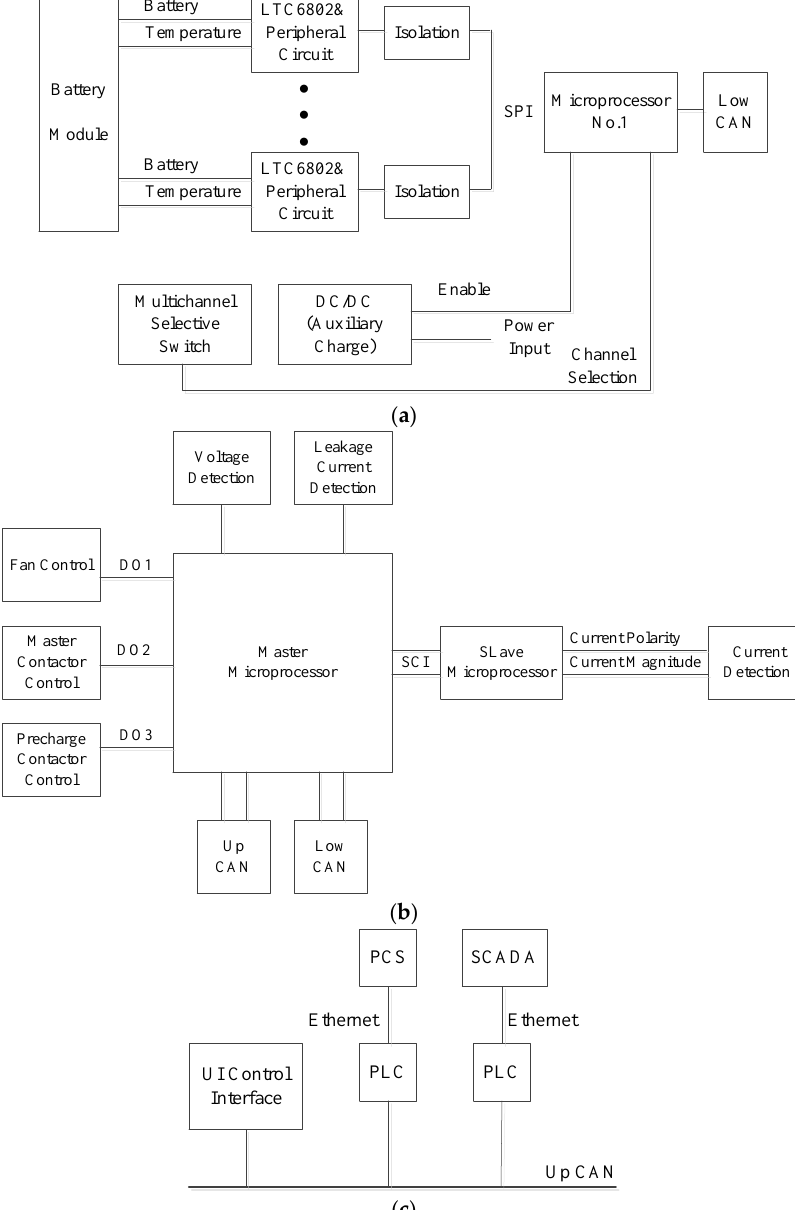
Figure 9. Battery management control circuits: ( a ) Single battery management and ( b ) Battery cluster management and ( c ) Battery array management.